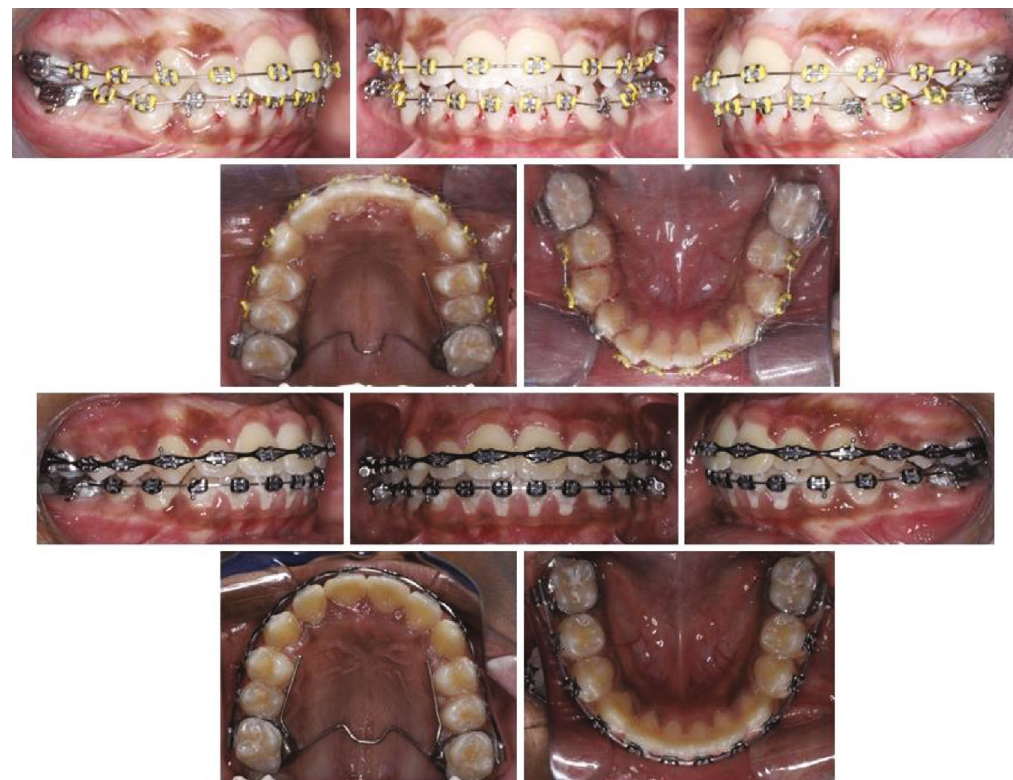
Figure 5: Bonding of the lower arch and fi nishing.